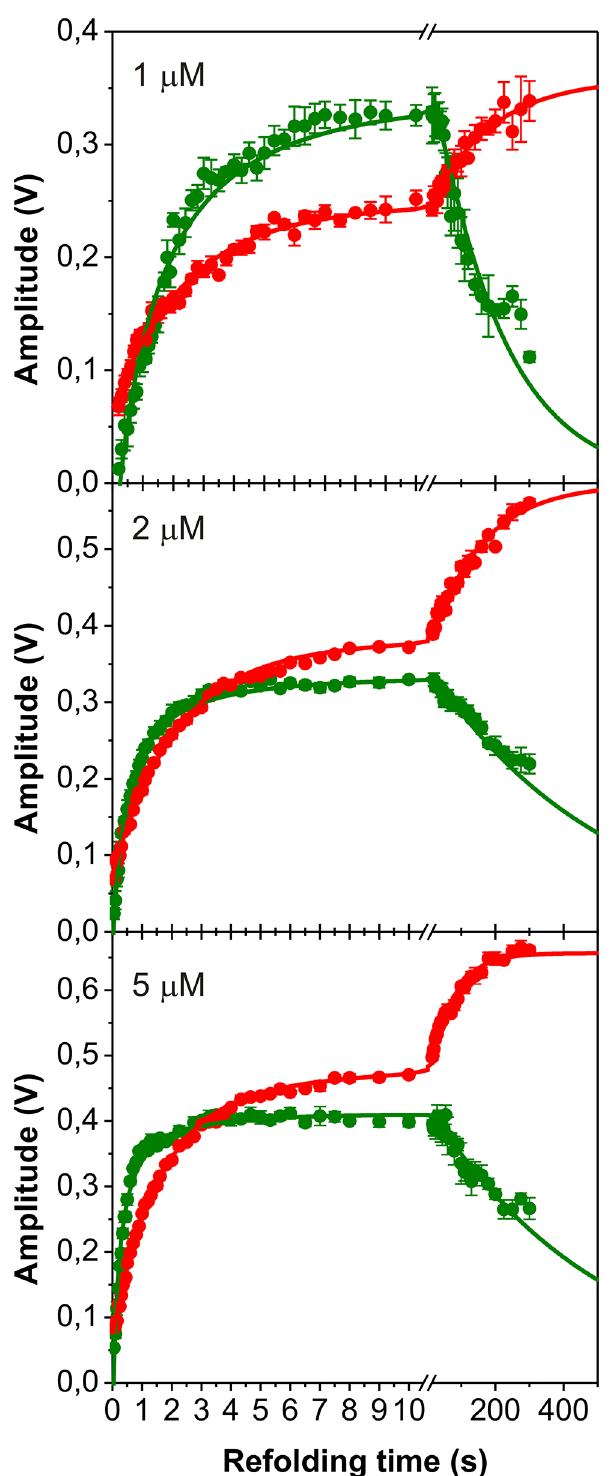
Fig 6. Double mixing refolding kinetics of N-BAR (N assay). The amplitude plot of the double mixing experiment reveals the time course of population of native and intermediate species during refolding. Amplitudes of the fast unfolding reaction are labeled by green symbols and amplitudes of the slow unfolding reaction are depicted in red. The final protein concentration is indicated in the plot. Continues lines represent